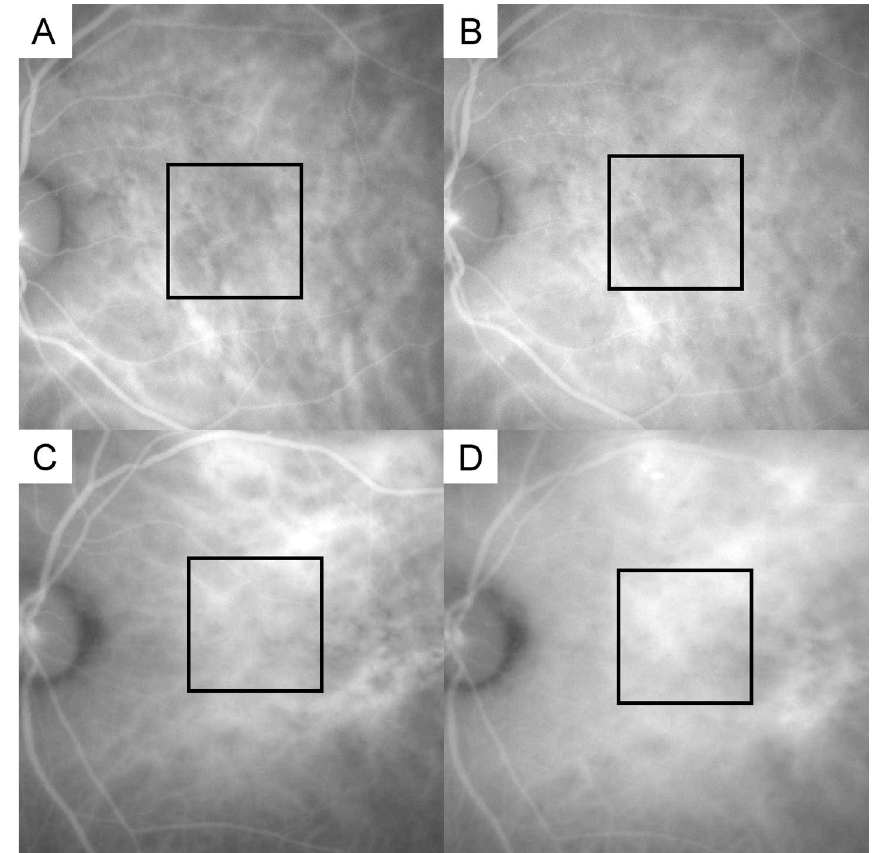
Figure 2. Representative images of choroidal vascular hyperpermeability status grading. The square represents a 5 × 5 mm 2 area corresponding to the OCTA image. ( A , C ) ICGA images taken 5 min after the dye injection, as a benchmark for comparison. ( B , D ) ICGA images taken about 10 min after the dye injection, to evaluate the CVH status in the square. ( B ) Scored 1 (CVH[−]): compared with ( A , B ) has no choroidal vascular hyperpermeability. ( D ) Scored 2 (CVH[+]): compared with ( C , D ) has obvious and strong choroidal vascular hyperpermeability. CVH[−]: PCV fellow eyes without choroidal vascular hyperpermeability. CVH[+]: PCV fellow eyes with choroidal vascular